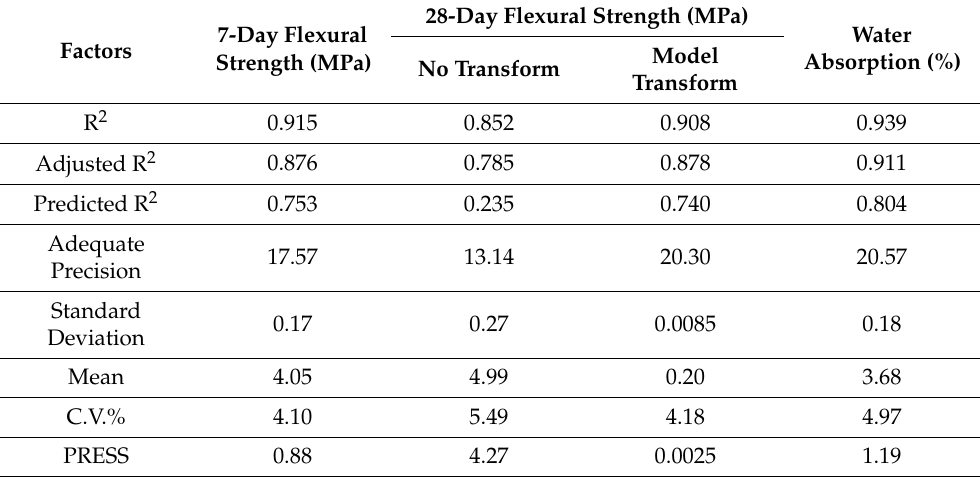
Table 11. Co-efficient of Regression ANOVA for flexural strength and water absorption